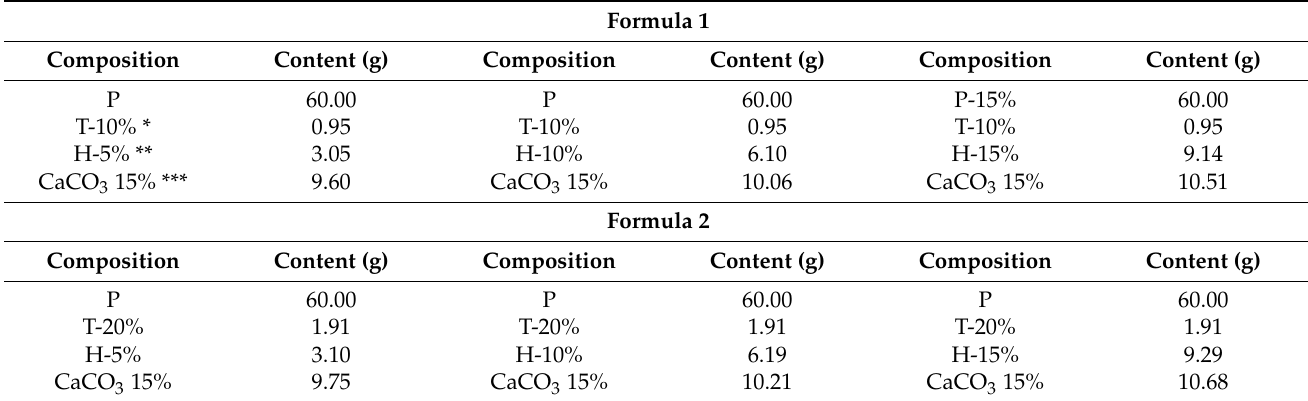
Table 1. Formulation of PVOH–tannin–hexamine (PTH)-based adhesive at different hexamine and tannin